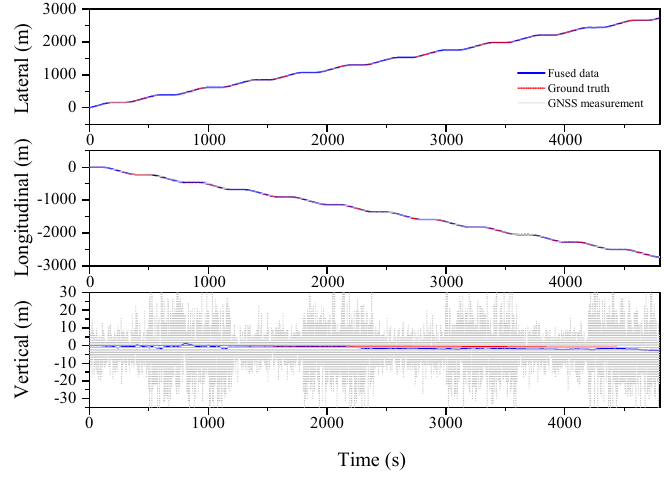
Figure 11. Lateral, Longitudinal and Vertical positions of ESKF (Serpentine 2).